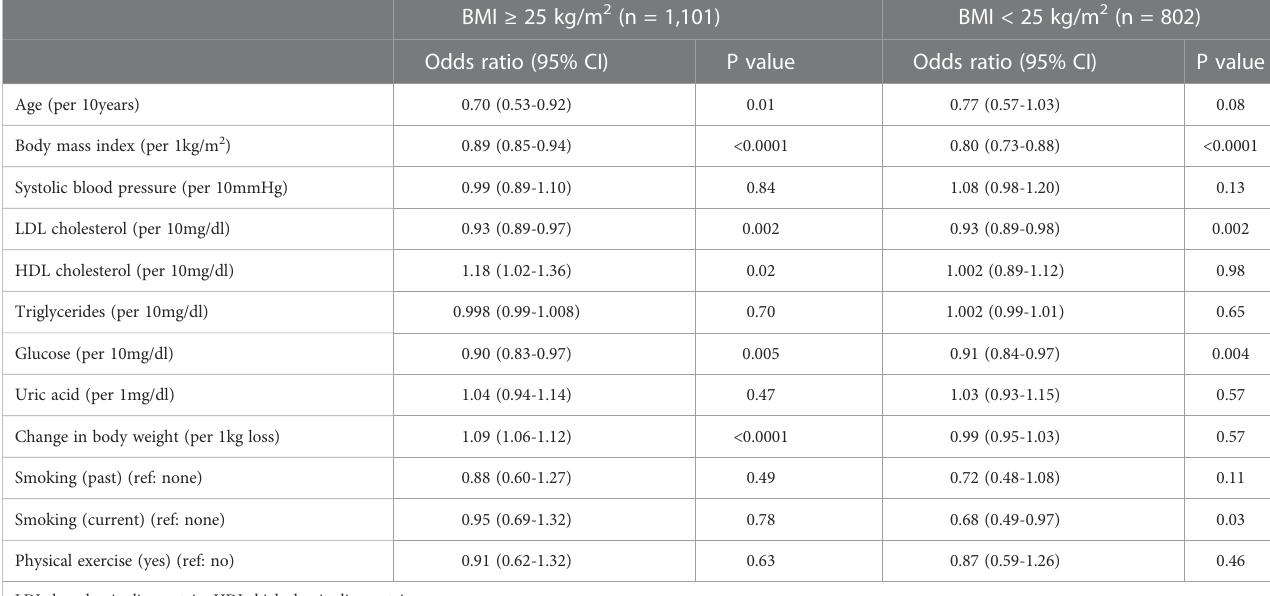
TABLE 3 Adjusted odds ratios for type 2 diabetes remission according to BMI